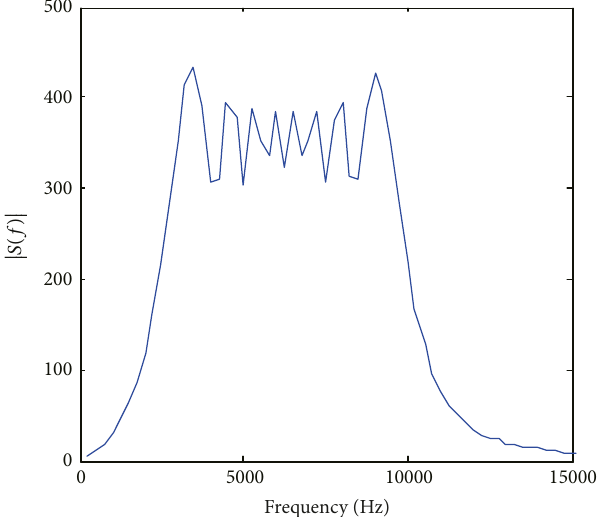
Figure 10: Results of outlier data mining in a mobile internet-based large real-time database.